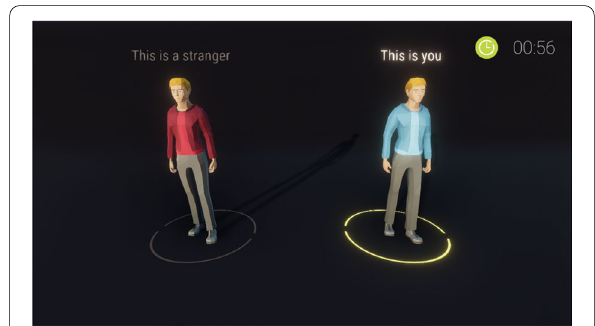
Fig. 5 Two avatars for the matching task. The condition for the player was highlighted with the green circle and the highlighted text. In this case, the right avatar in the blue shirt would have been the avatar representing the participant in the task and the left avatar in the red shirt would have been representative of some stranger